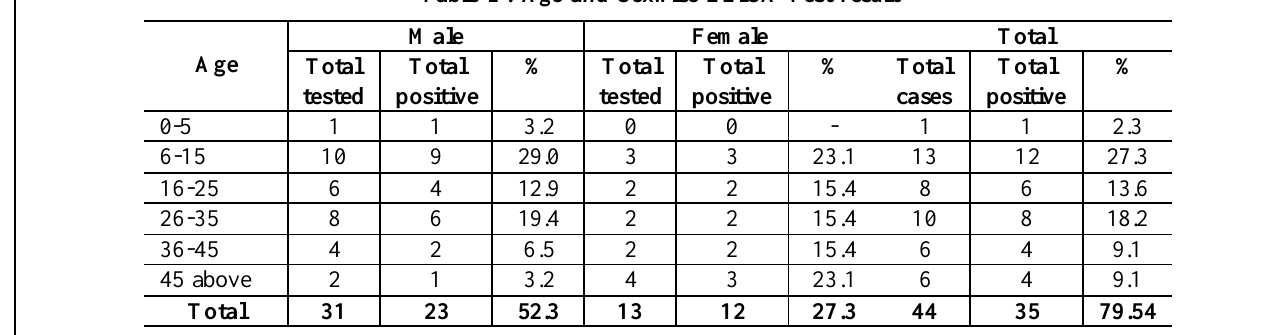
Table I : Age and Sexwise ELISA Test